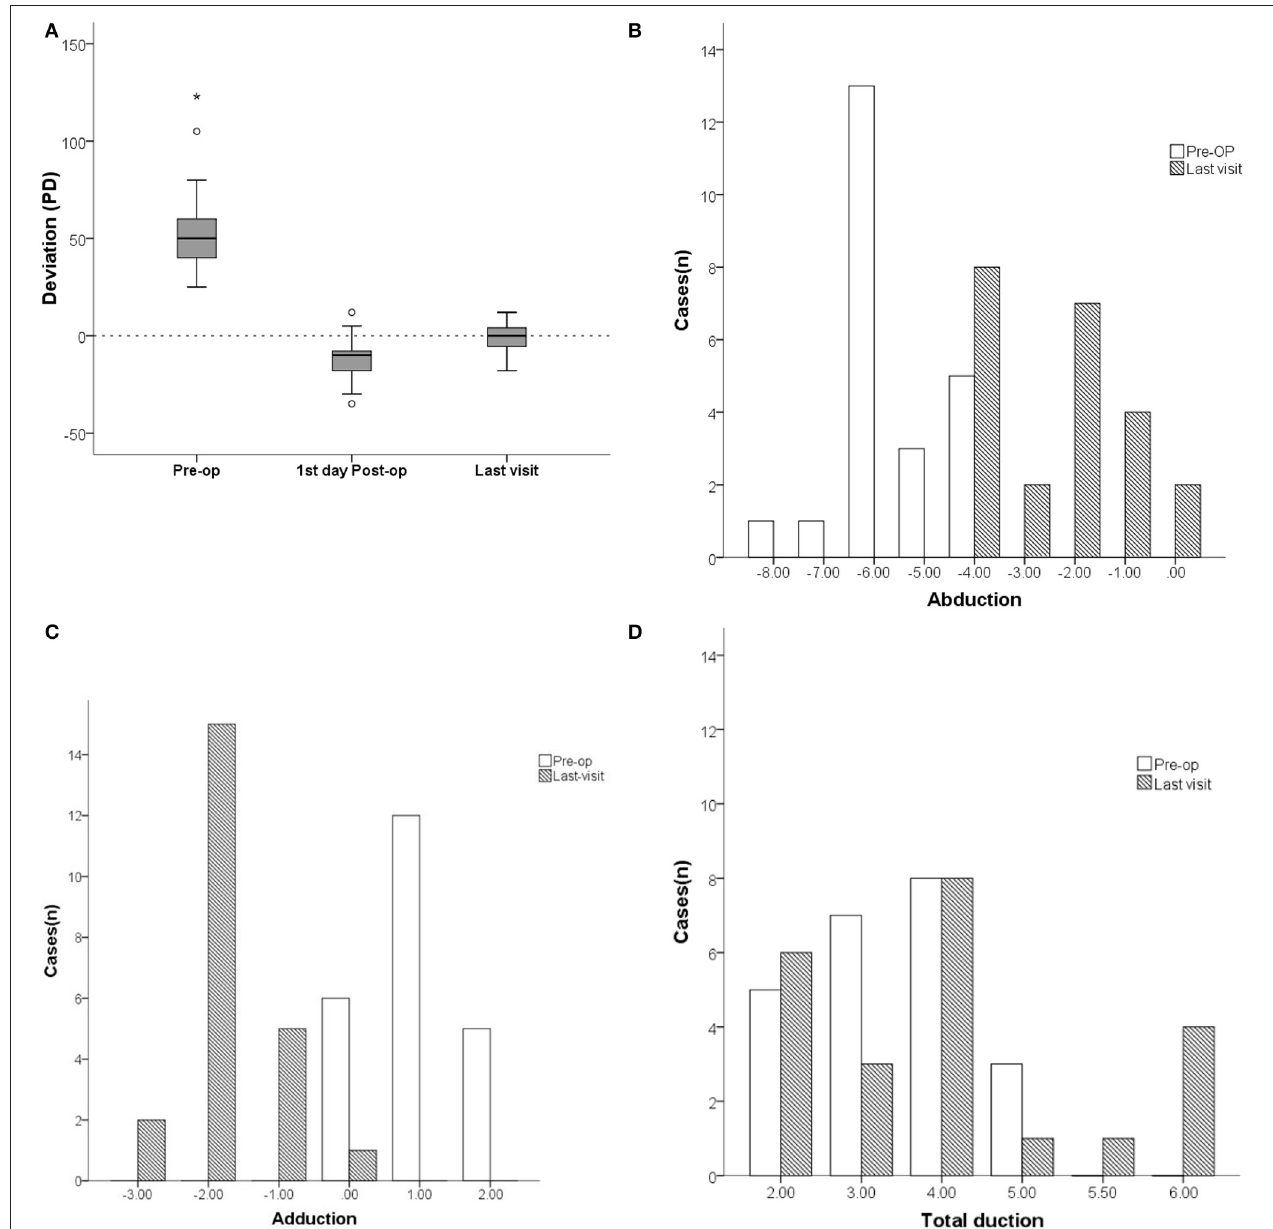
FIGURE 1 | Comparison of deviation (PD) and ocular motility between pre- and postoperation of patients with unilateral complete abducens nerve plasy. (A) The mean pre-operative horizontal esodeviation of 55.5 ± 27.2 PD (range: + 25 to + 123) significantly improved to − 11.5 ± 11.0 PD (range: − 35 to + 12) on the first day after surgery, and further improved to 0.04 ± 7.3 PD (range: − 18 to + 12) as determined on their last visit. (B) The mean abduction function increased form − 5.6 ± 1.0 (range: − 8 to − 4) preoperatively to − 2.4 ± 1.4 (range: − 4 to 0) on their last visit. (C) The mean adductions of the paretic eye decreased from 0.0 ± 0.0 (range: 0 to + 2) pre-operatively to a mean deficiency of − 1.8 ± 0.7 (range: − 3 to 0) on their last visit. (D) The mean duction ranges in the paretic eye increased from 2.4 ± 1.0 pre-operatively to 3.8 ± 1.4 on their last visit. In the box plot (A) , the value that is more than 1.5 times the distance from the quartile value is the outlier and is represented by “o”, while the value that is more than 2 times is the extreme value and is marked by “*”. Pre-op,